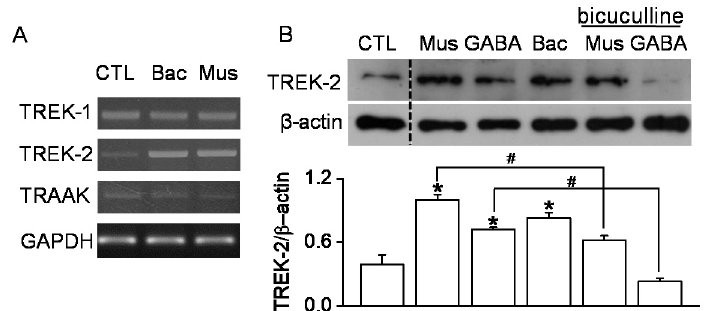
Figure 3. Upregulation of TREK-2 by the GABA receptor agonists baclofen and muscimol in B35 cells. ( A ) The alteration of TREK-1, TREK-2, and TRAAK mRNA expression levels via treatment with baclofen or muscimol. B35 cells were treated with the chemicals (100 μ M) for 24 h. ( B ) The TREK-2 protein expression level affected by GABAR modulators. Each bar represents the mean ± SD of four independent experiments. * p < 0.05 compared to the control. # p < 0.05 compared to each corresponding treatment. CTL, Bac, and Mus represent the control, baclofen, and muscimol, respectively.